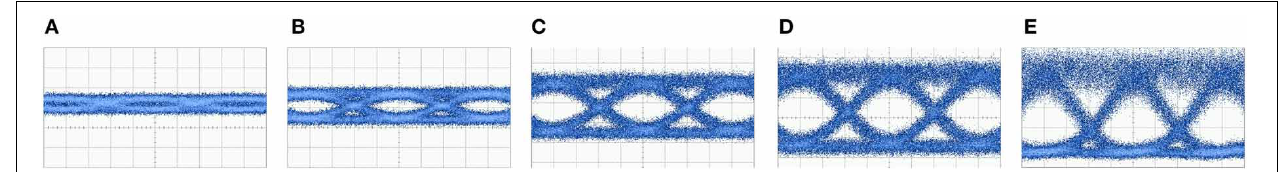
FIGURE 9 | 25-Gbps eye patterns for device #1 with linear junction, middle doping concentration, and L = 200- µ m. (A–E) correspond to those in Figure 1 . PRBS signal consists of 2 7 –1 bit.